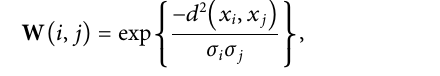
Frontiers in Genetics |